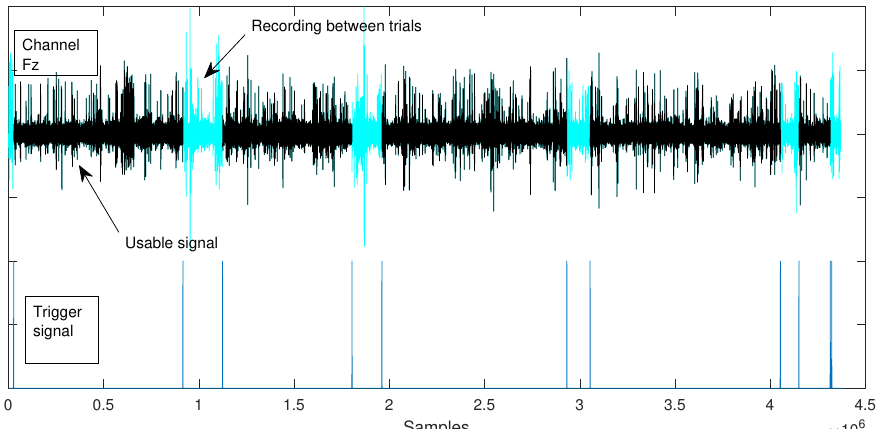
Figure 1. Continuously recorded Fz channel along with the auxiliary trigger channel. The onset and offset of every trial are marked with a narrow pulse in the auxiliary trigger channel. An extra pulse marks the end of the experiment session. In this experiment, five different trials were presented to the